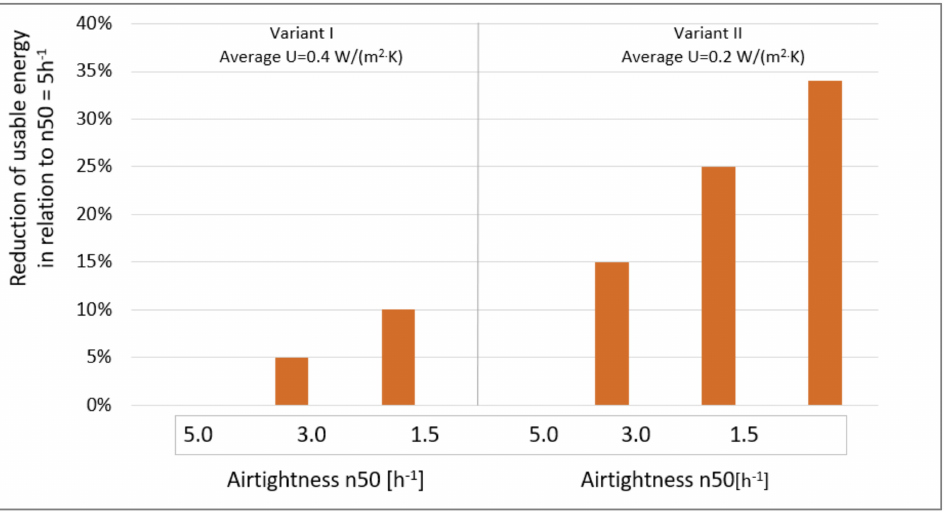
Figure 3. Reduction in usable energy for heating and ventilation in relation to the case n 50 =